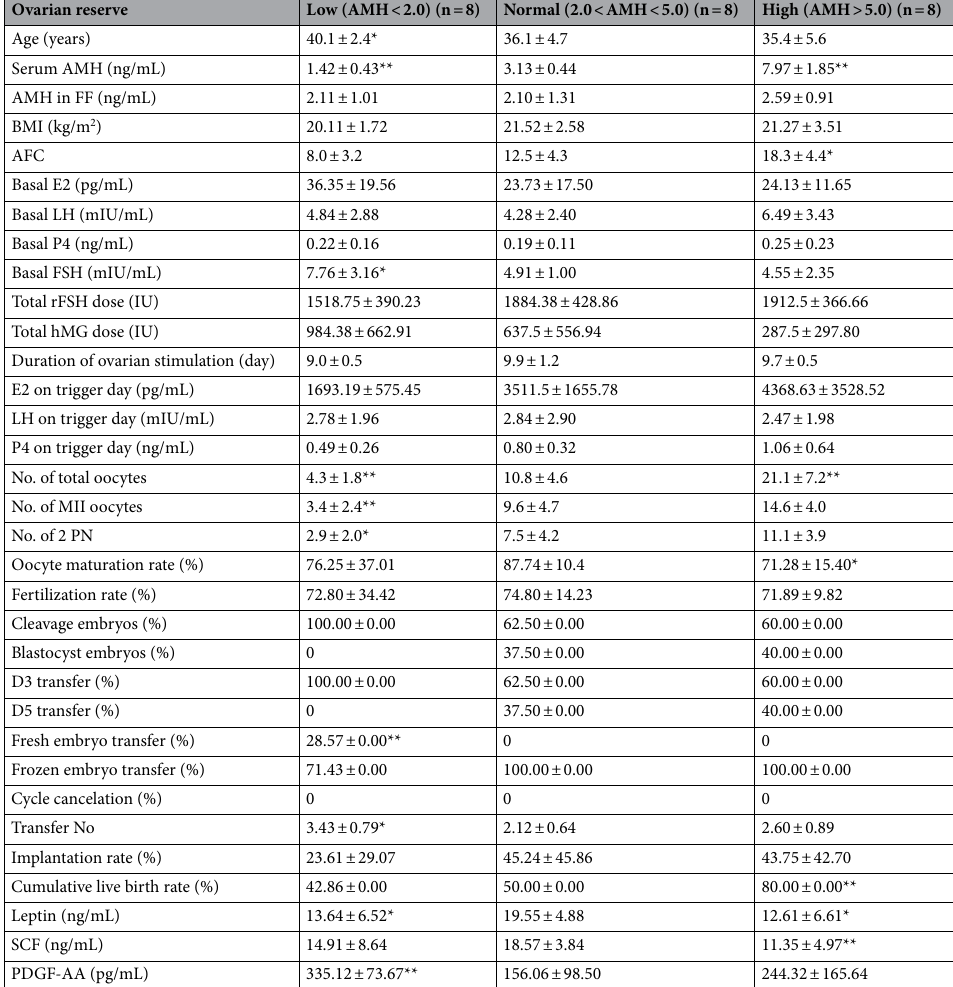
fluid, BMI body mass index, E2 estradiol, LH luteinizing hormone, P4 progesterone, FSH follicle-stimulating hormone, MII metaphase II, 2PN two pronuclei, rFSH recombinant follicle stimulating hormone, hMG human menopausal gonadotropin, SCF stem cell factor, PDGF-AA platelet-derived growth factor AA. Mann–Whitney U test, *mean p < 0.05; **mean p < 0.01: compared to normal